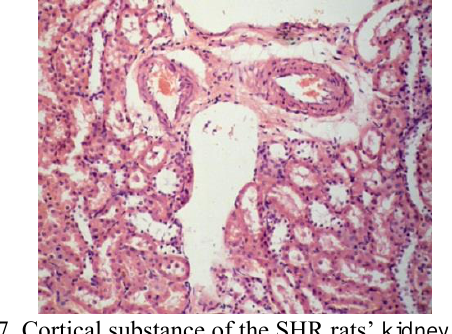
Fig. 7. Cortical substance of the SHR rats’ kidney. Com- bined long-term therapy (ramipril and corvitin). There are no signs of endothelial cells with desquamation.